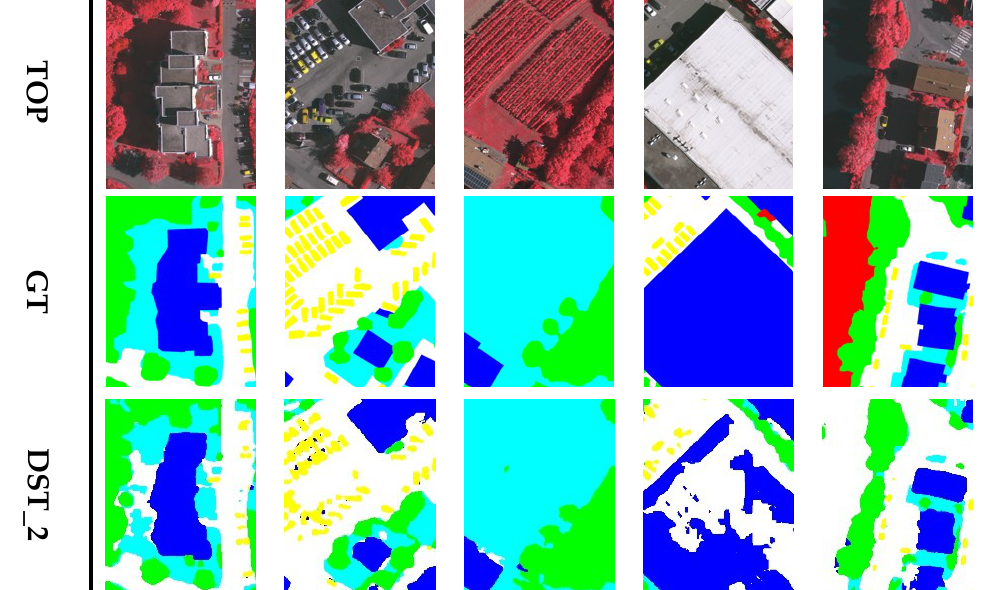
Table 2. Experimental results on the (ISPRS) Vaihingen challenge online test